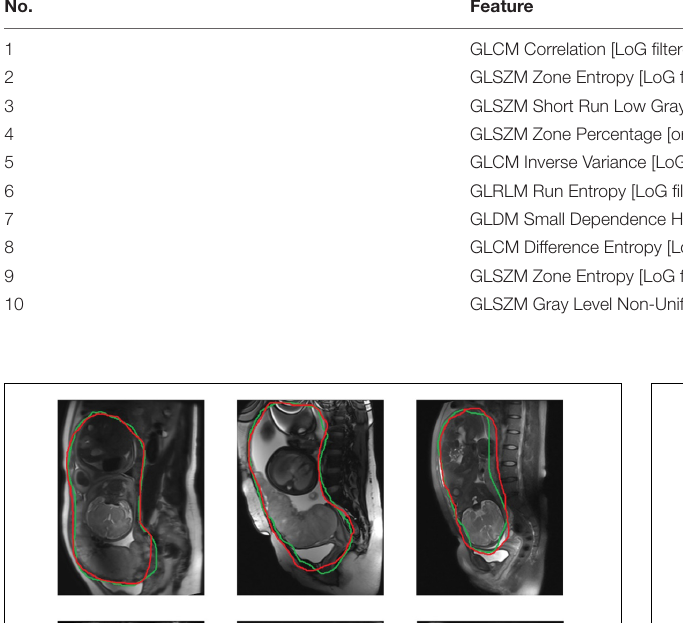
TABLE 2 | The top 10 features with the most predictive power. No.